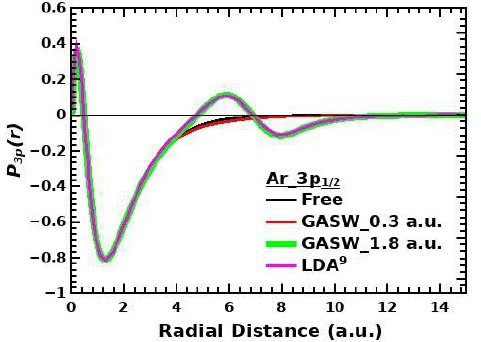
Figure 1. The large component of 3p 1/2 radial wavefunction of free and confined Ar. Table 1. 3 p subshell thresholds of free and confined Ar.